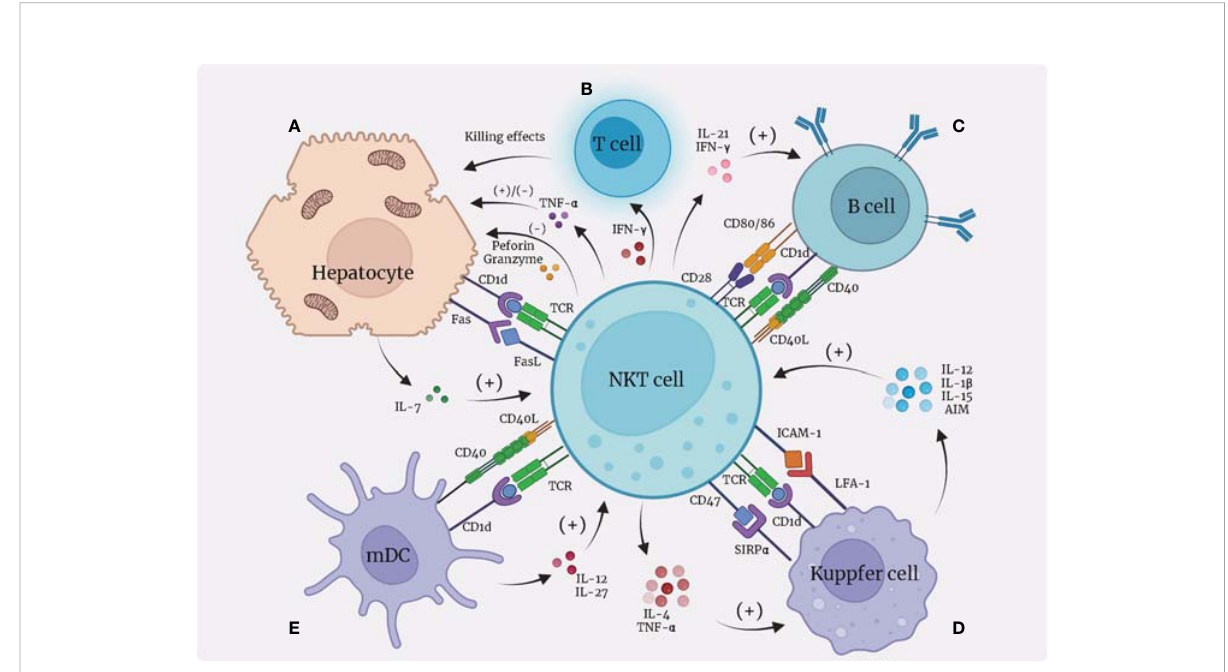
FIGURE 2 Interactions between NKT cells and hepatocytes, dendritic cells, Kupffer cells, and B cells. (A) Hepatocytes present lipid antigens to TCR on NKT cells via the CD1d-dependent pathway; hepatocytes release IL-7 to activate NKT cells; NKT cells secrete TNF- a that has dual functions on hepatocytes; NKT cells express FasL and induce Fas expression on hepatocytes, leading to apoptosis of hepatocytes. (B) NKT cells secrete IFN- g to recruit T cells to kill hepatocytes. (C) B cells present lipid antigens to NKT cells through CD1d; NKT cells and B cells contact each other directly through CD40L/CD40 and CD28/CD80, 86; NKT cells secrete IL-21 and IFN- g to promote B cells. (D) Kupffer cells present lipid antigens to TCR on NKT cells via the CD1d-dependent pathway; Kupffer cells express LFA-1 and SIRP a , which bind with ICAM-1 and CD47, respectively, on NKT cells to activate NKT cells; Kupffer cells secrete IL-12, IL-1 b , IL-15, and AIM to recruit and promote NKT cells; NKT cells in return produce pro-in fl ammatory IL-4 and IFN- g to function on Kupffer cells. Notably, over-stimulation of NKT cells by Kupffer cells leads to apoptosis of NKT cells. (E) Dendritic cells (especially myeloid dendritic cells, mDC) present lipid antigens via CD1d towards NKT cells to activate NKT cells; dendritic cells secrete IL-27 and IL-12 to activate NKT cells; NKT cells express CD40L to bind with CD40L and reciprocally bene fi t